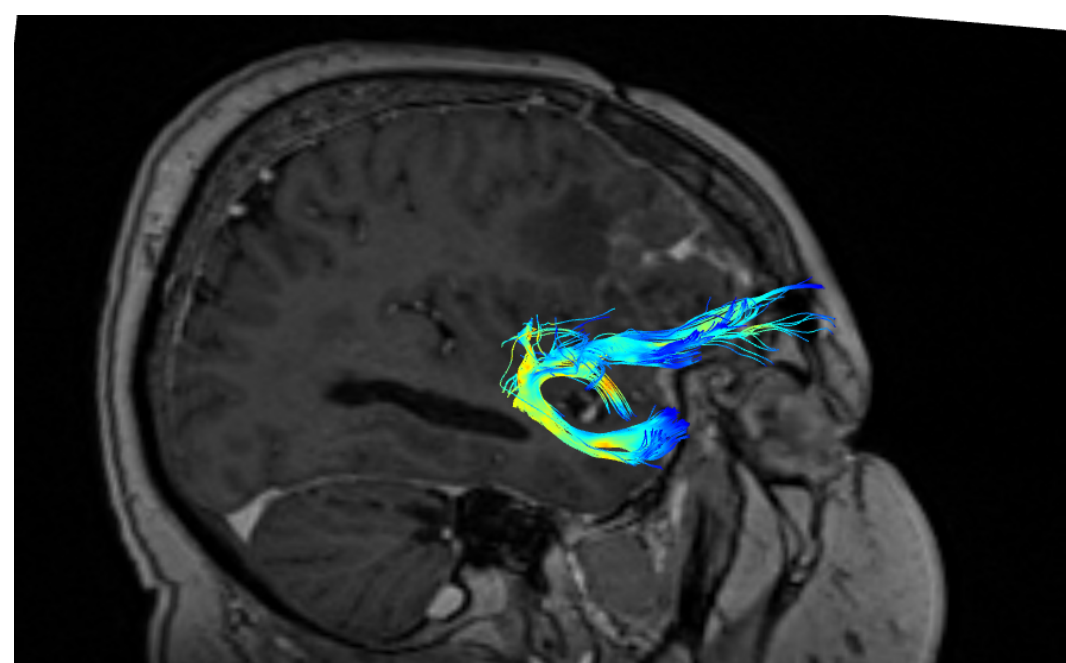
Figure 4. Y-shape of the uncinate fasciculus (UF).